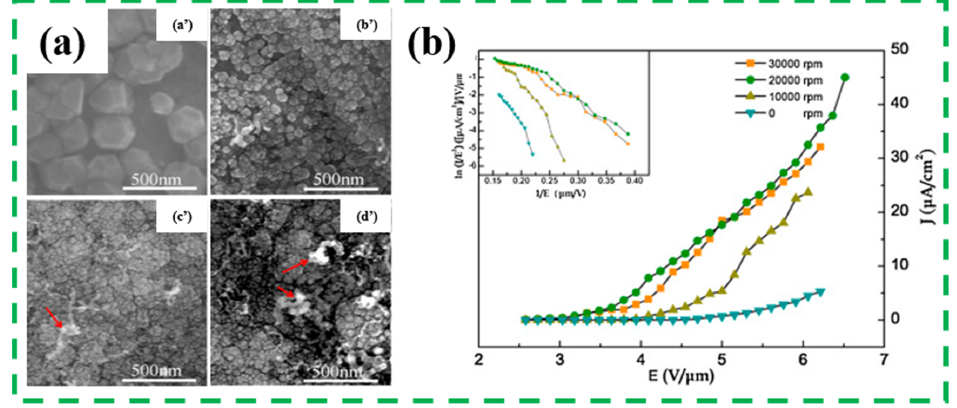
Figure 7. ( a ) The SEM images of the deposited ND film with different angular frequency ω of 0 rpm ( a’ ), 10,000 rpm ( b’ ), 20,000 rpm ( c’ ), 30,000 rpm ( d’ ). Additionally, ( b ) the corresponding J - E plots [88].